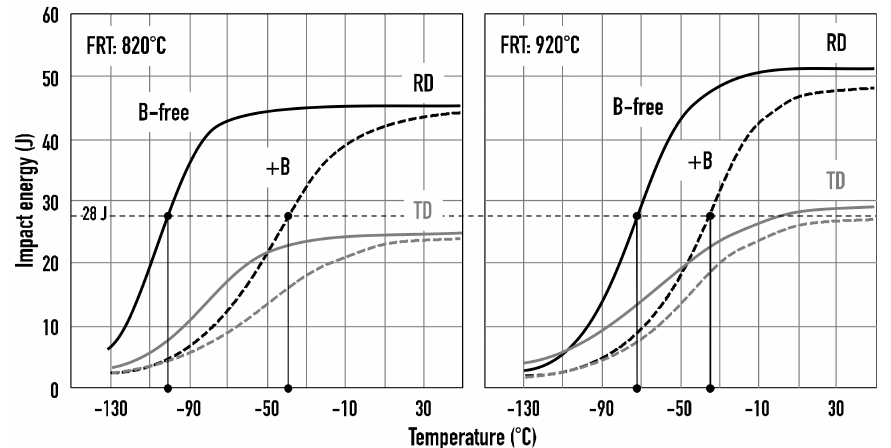
Figure 12. Anisotropy (black curve: rolling direction (RD), gray curve: transverse direction (TD)) of ductile-to-brittle transition behavior of direct quenched 0.08% C-1.8% Mn-1.1% Cr-0.15% Mo-Nb steel and influence of boron addition (solid line B-free, dashed line B-added) at two finish-rolling temperatures